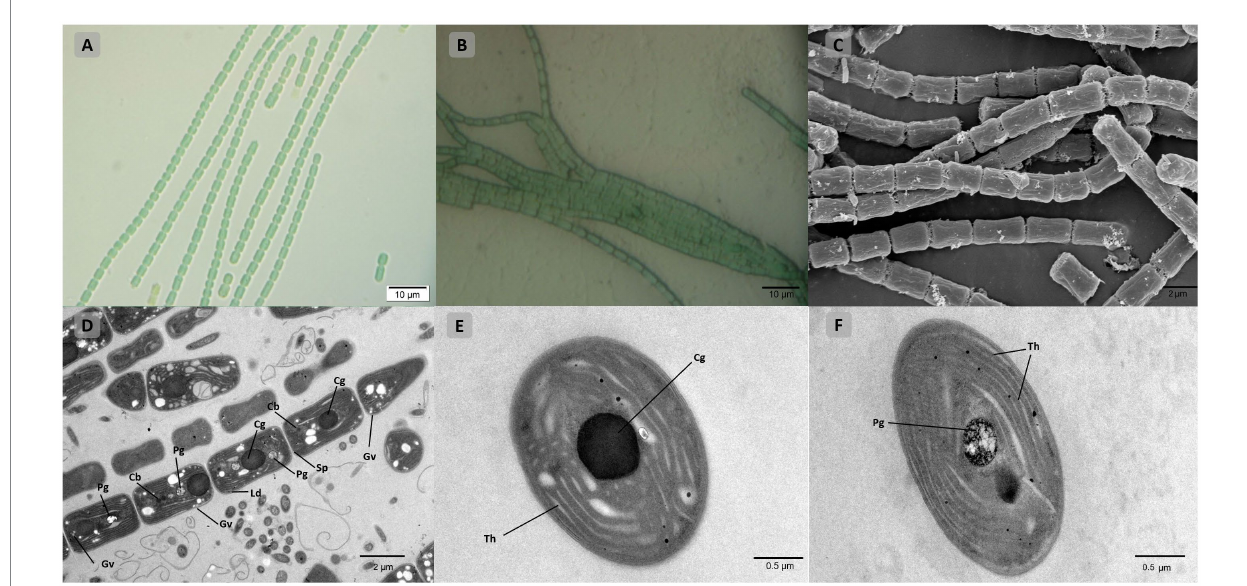
FIGURE 7 Microscopic morphology of Trichothermofontia B231. (A) Light microscopy image of liquid-medium grown cultures; (B) light microscopy image of solid-medium grown cultures; (C) SEM image; (D–F) TEM images. Cb, carboxysome; Cg, cyanophycin granule; Ld, lipid droplets; Pg, polyphosphate granule; Sp, septum; Th, thylakoid membrane, Gv, gas vesicles. Magnifications were 1,000× (A,B) ; 5,000× (C,D) ; 20,000× (E,F)